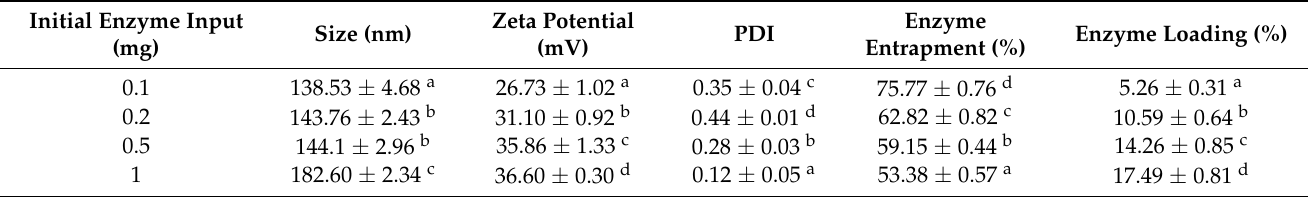
Table 1. Effect of different concentrations of enzyme input on size, zeta potential, polydispersity index (PDI), drug entrapment and drug loading in chitosan-PEGylated nanoparticles (CS-LO-PEG NPs). The results are presented as mean ± SE. Superscript letters on the values indicates significant differences between the data in the column ( p <